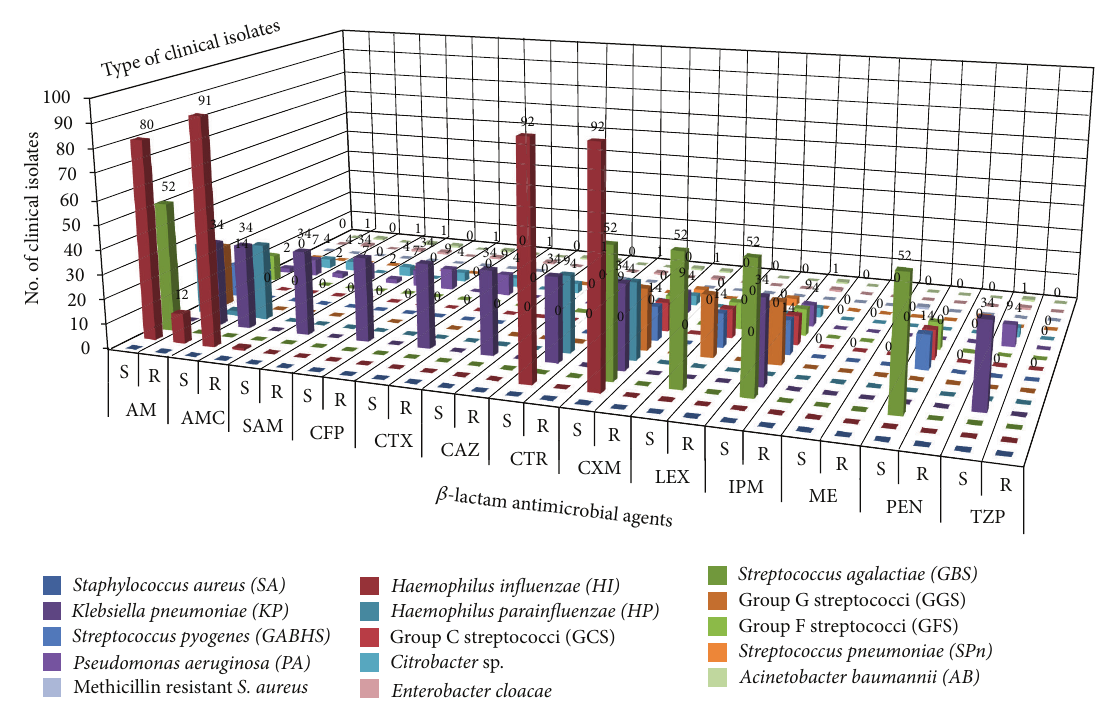
Figure 1: Antimicrobial susceptibility of tonsillar isolates against selected 𝛽 -lactam agents. AM: ampicillin, AMC: amoxicillin-Clavulanic acid, SAM: ampicillin-Sulbactam, CFP: cefoperazone, CTX: cefotaxime, CAZ: ceftazidime, CTR: ceftriaxone, CXM: cefuroxime, LEX: cephalexin, IPM: imipenem, ME: methicillin, PEN: penicillin, TZP: piperacillin-Tazobactam. (S) indicates susceptible isolates and (R) indicates resistant